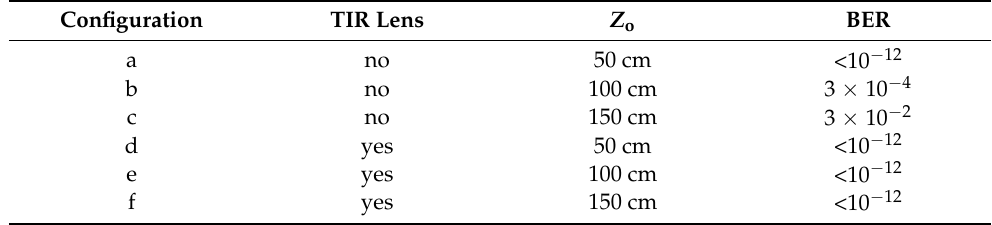
Figure 7. Eye diagrams for PRBS-7 signals with a bit rate of 1.289 Gbit/s. ( a ) No lens ( Z o = 50 cm), ( b ) no lens ( Z o = 100 cm), ( c ) no lens ( Z o = 150 cm), ( d ) with lens ( Z o = 50 cm), ( e ) with lens ( Z o = 100 cm), ( f ) with lens ( Z o = 150 cm). The observed bandwidth is 3 GHz. Table 2. Numerical results of the